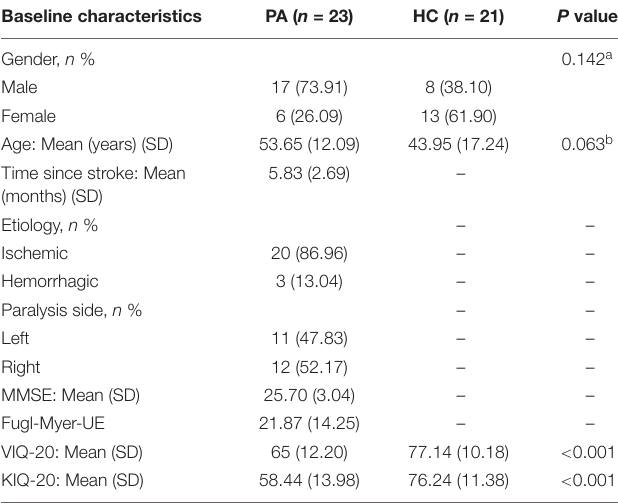
TABLE 1 | Demographic material of patients and healthy